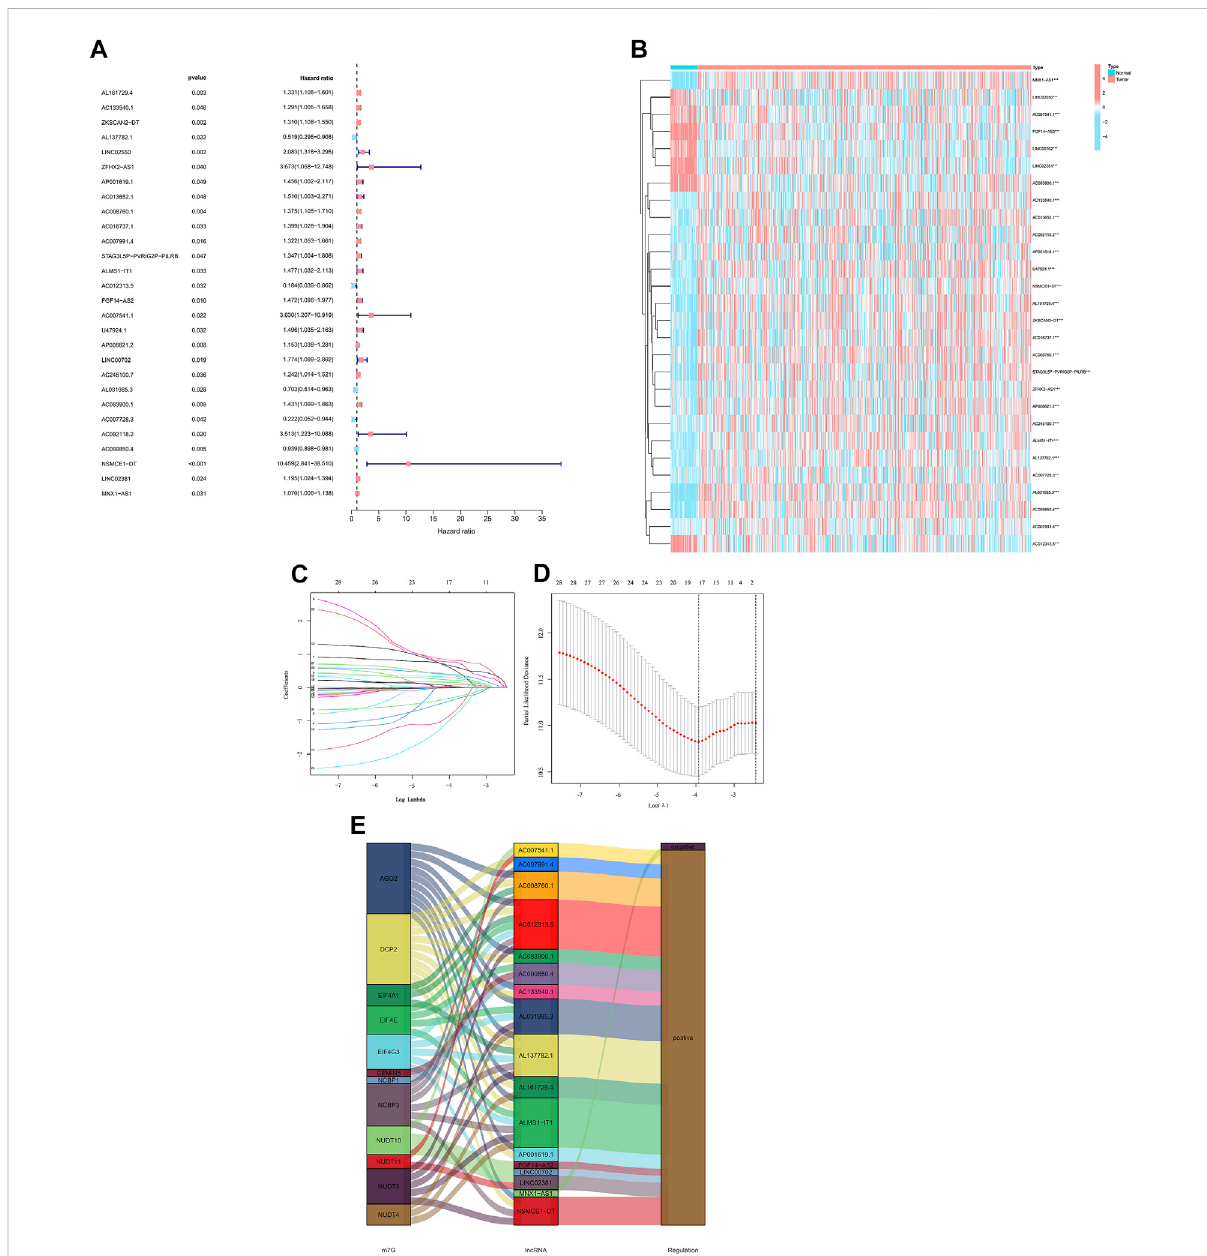
FIGURE 3 Analysis of the prognostic value of m7G-related lncRNAs in CRC. (A) Identi fi cation of prognostic lncRNAs using univariate Cox regression. (B) Prognostic lncRNA expression pro fi les of 28 genes. (C) Cross-validation of the LASSO model for variable selection in a 10-fold